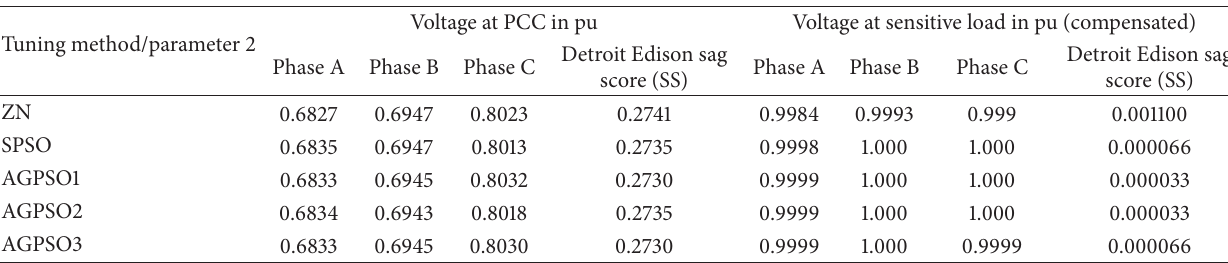
Table 6: Voltage sag compensation of rectifier load.